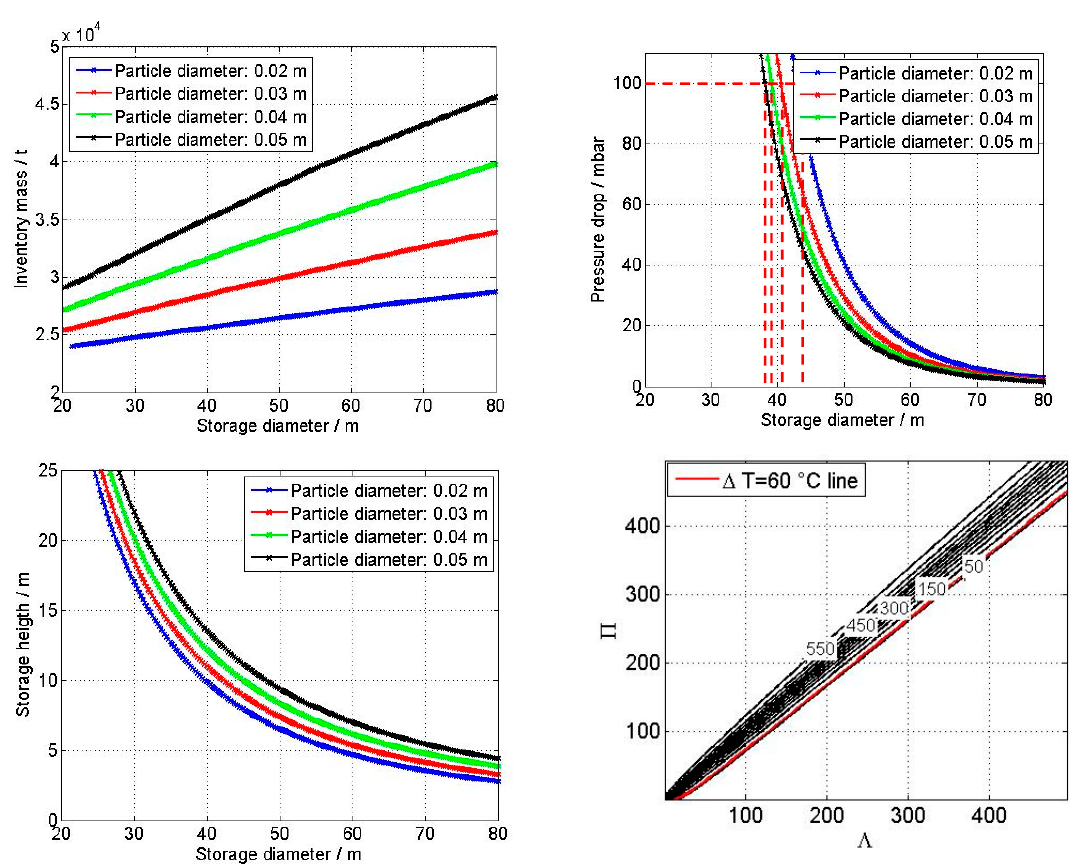
Figure 4. Simulation results of designing the TES.